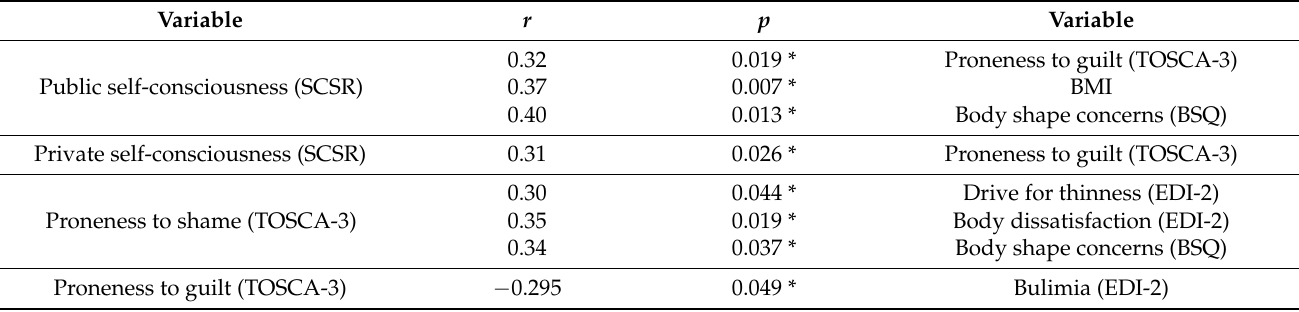
Table 5. Pearson correlations in AN individuals.